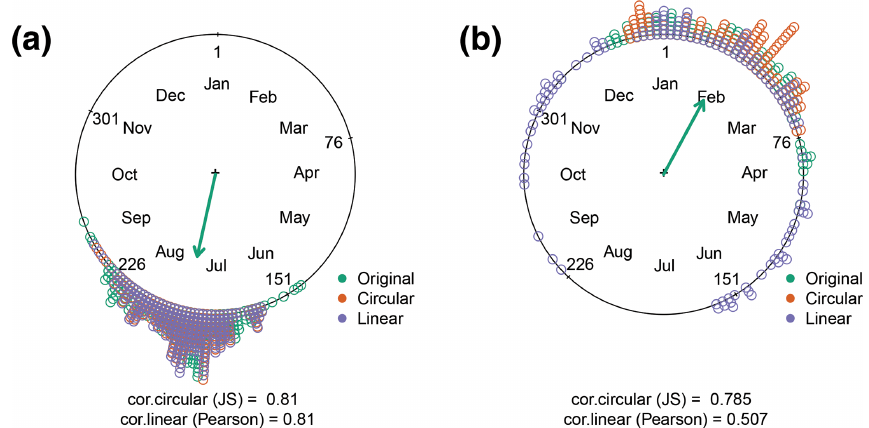
Figure 4. Correlation coefficient between the observed and predicted DOY GPPmax using climatic variables. Two sites are presented: (a) US-Ha1 and (b) AU-How. The observed DOY GPPmax (green) is compared with the data retrieved using circular (orange) and linear (purple) regressions. Two correlation coefficients are used: Jammalamadaka–Sarma (JS) and the Pearson product moment (Pearson). In the circular plot the months and the day of the year (DOY) are also plotted every 75d. The green arrow indicates the mean angular direction of the original data